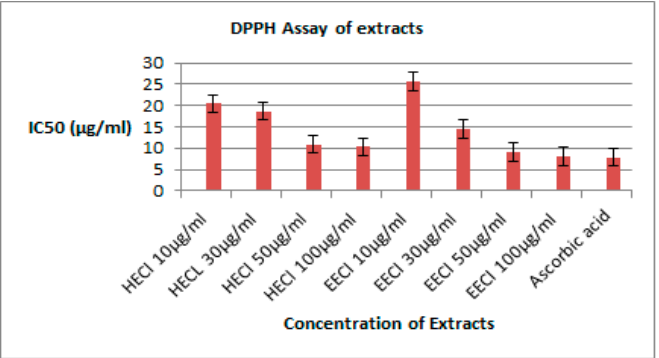
Figure 2. DPPH free radical scavenging of HECl and EECl at different doses.